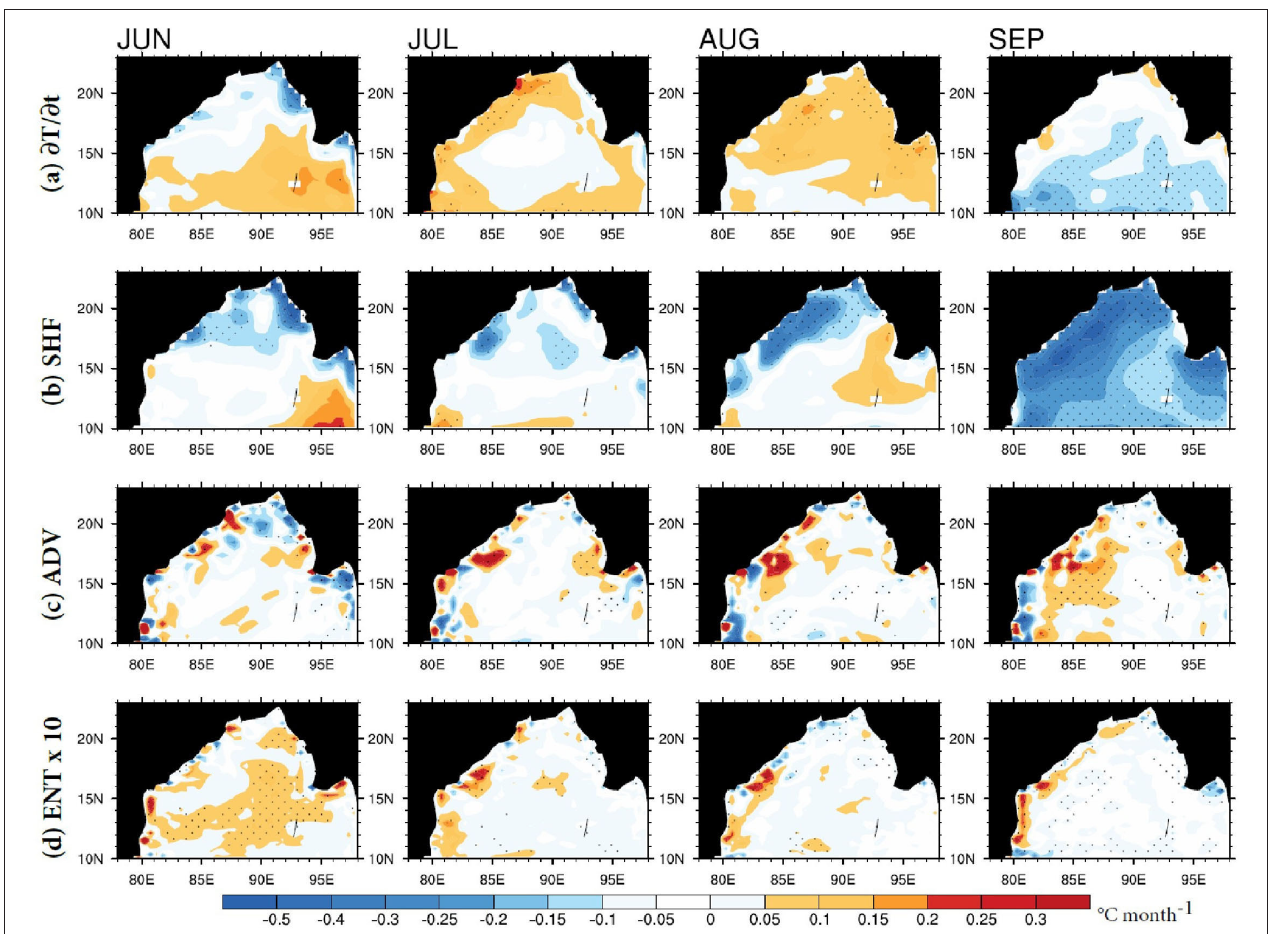
FIGURE 7 | Difference (RIV-CTL) between the mixed layer heat budget terms ( ◦ C month − 1 ) for panel (a) temperature tendency, (b) surface heat flux, (c) advection, (d) entrainment at the base of the mixed layer.